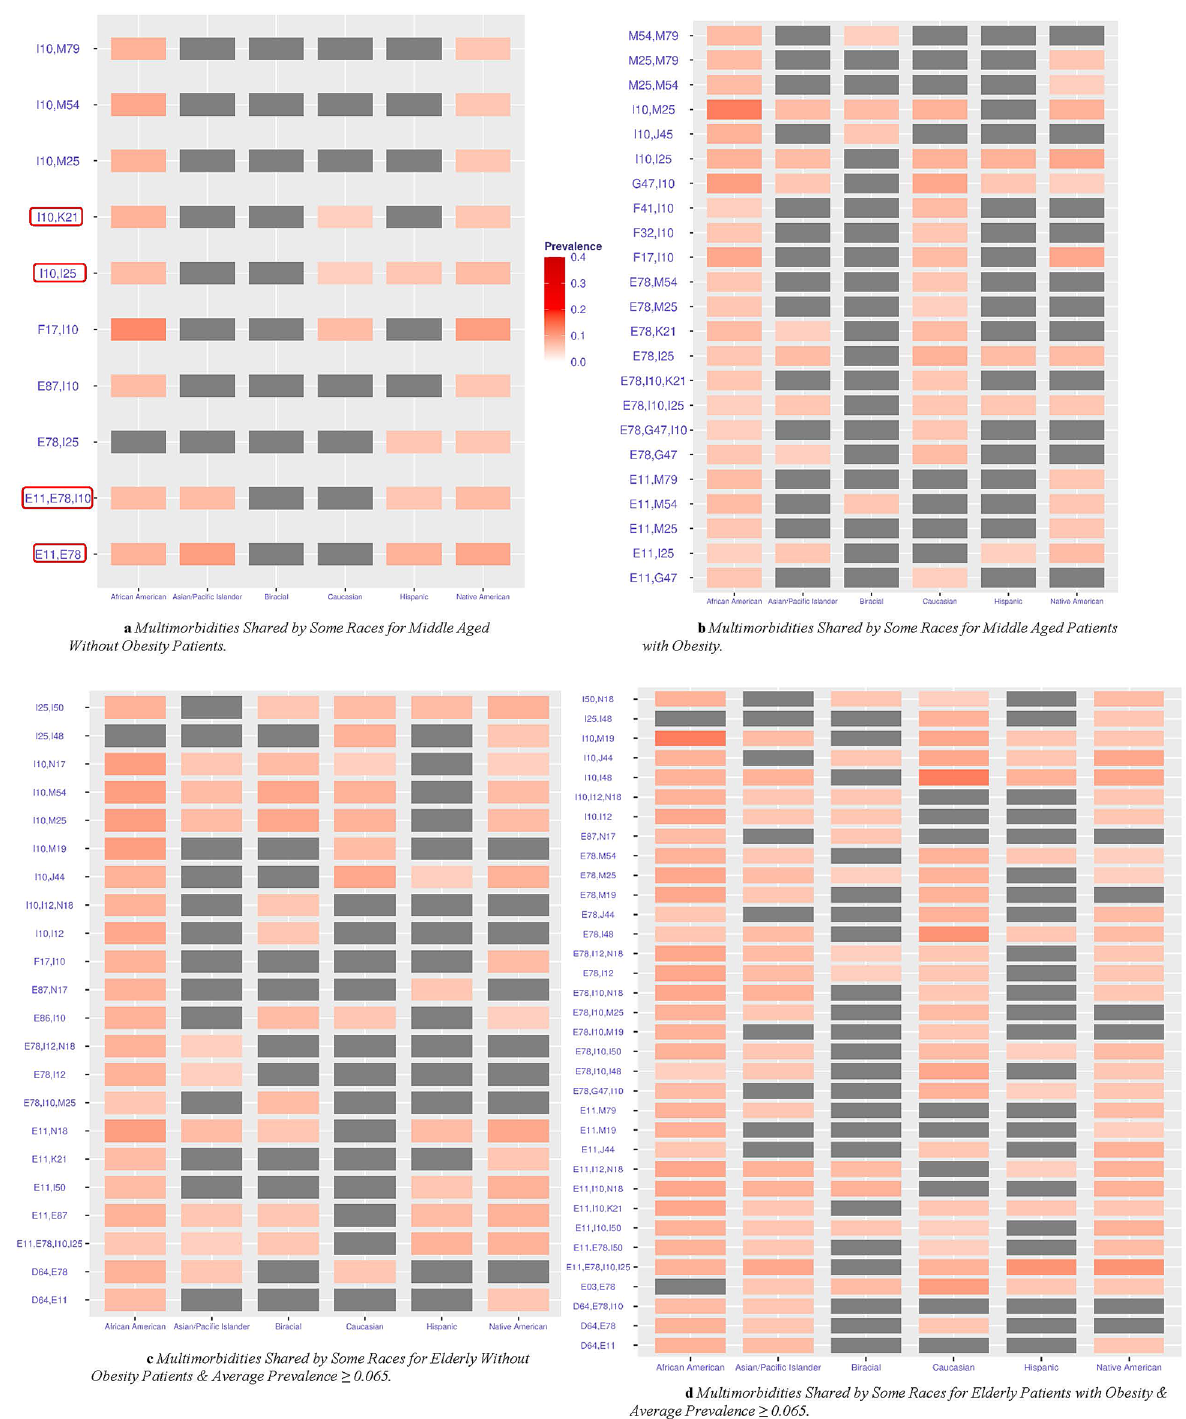
Figure 2. ( a , b ) Show shared multimorbidities across two or more races in middle aged patients without and with obesity, respectively, at 5% prevalence threshold. Gray sectors indicate the combination was not prevalent above the 5% threshold for a given group. The g-test of independence was calculated resulting in all significant results with p < 0.05 except for red boxed multimorbidity pattern(s) indicating non-significant result. ( c , d ) Demonstrate the shared multimorbidities among two or more races in the elderly patients without and with obesity, respectively, at 5% prevalence threshold. The g-test was calculated resulting in all significant results with p < 0.05 except for the multimorbidity patterns circled in red. Disease Clinical Categories; E: Endocrine, nutritional and metabolic, F: Mental, behavior and neurodevelopmental, G: Nervous System, I: Circulatory system, J: Respiratory system, K: Digestive system, N: Genitourinary system, M: musculoskeletal system and connective